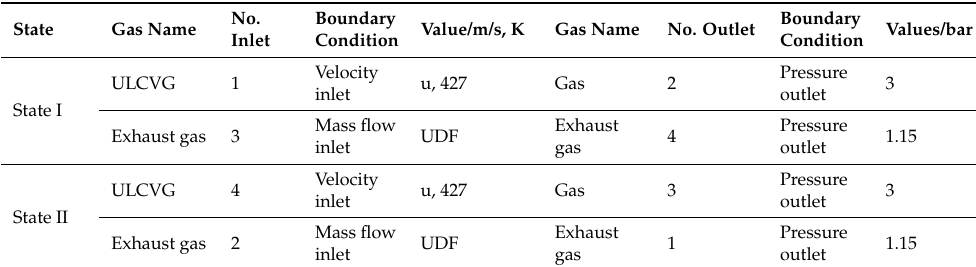
Table 2. Switch order and boundary